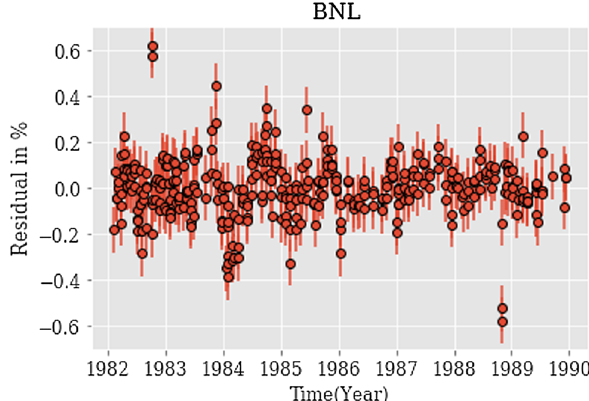
Fig. 5 Weighted L–S periodograms of 36 Cl decay rate data measured at the PTB for frequencies in the range 0–14 a − 1 ). The Z-scores are negligible and not shown